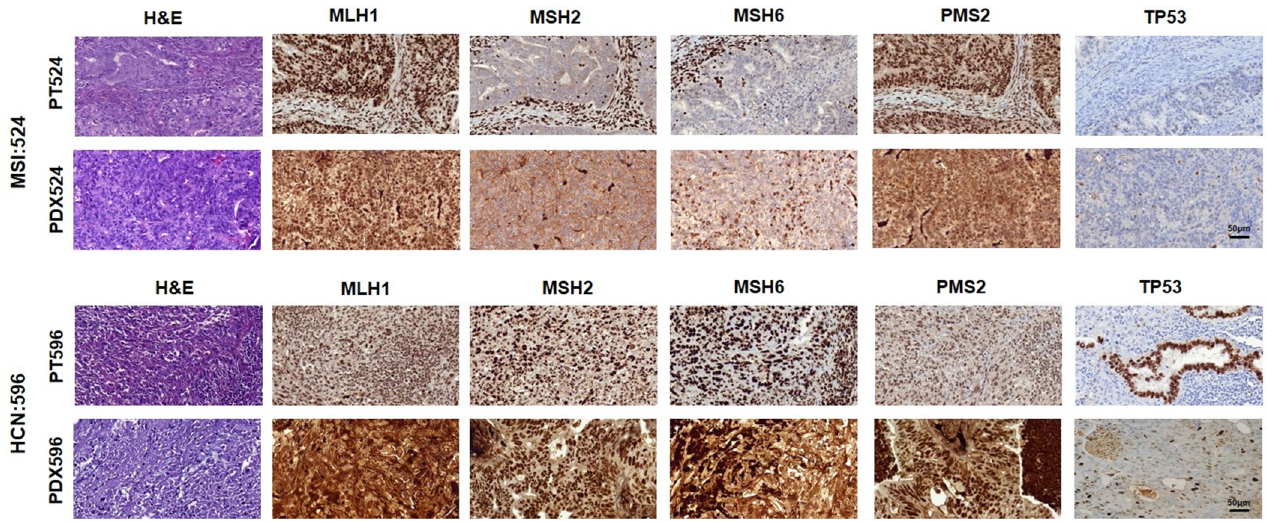
Figure 1. Patient-PDX histological characterization. Tumor tissue staining of a representative endo- metrioid/MSI EC patient and their PDX model (MSI:524, ( upper panel )) and a serous/HCN EC patient and their PDX model (HCN:596, ( lower panel )). Images show the hematoxylin and eosin (H & E) staining, as well as IHC of MMR proteins MLH1, MSH2, MSH6, PMS2, and TP53. Magnification 40×.